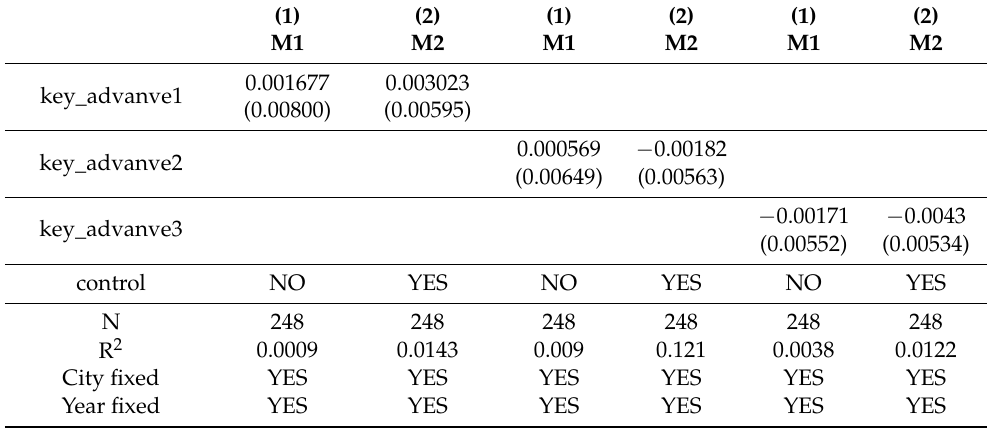
Table 4. Counterfactual test